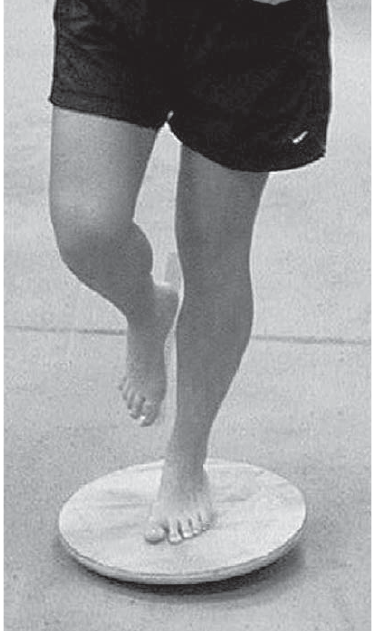
Fig. 1. A wobble-board rehabilitation exercise